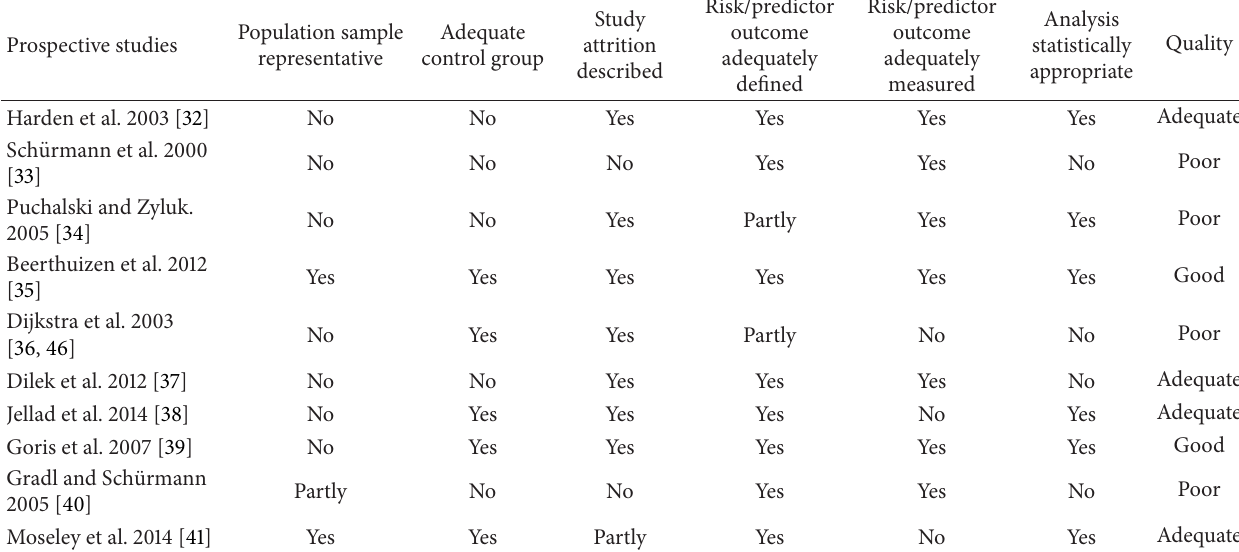
Table 5: Results presenting quality and relevance of data extraction for onset of CRPS 1 from prospective studies.